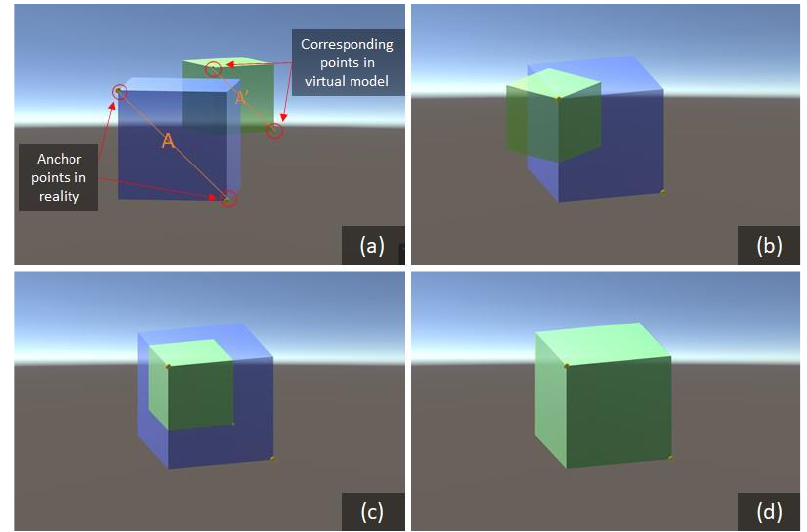
Figure 5. Selecting anchor points in reality.